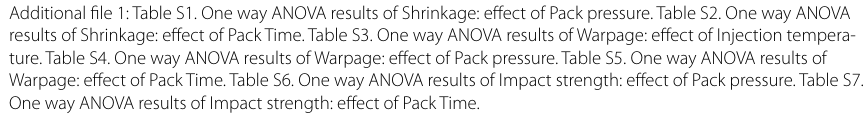
ture. Table S4. One way ANOVA results of Warpage: effect of Pack pressure. Table S5. One way ANOVA results of Warpage: effect of Pack Time. Table S6. One way ANOVA results of Impact strength: effect of Pack pressure. Table S7. One way ANOVA results of Impact strength: effect of Pack